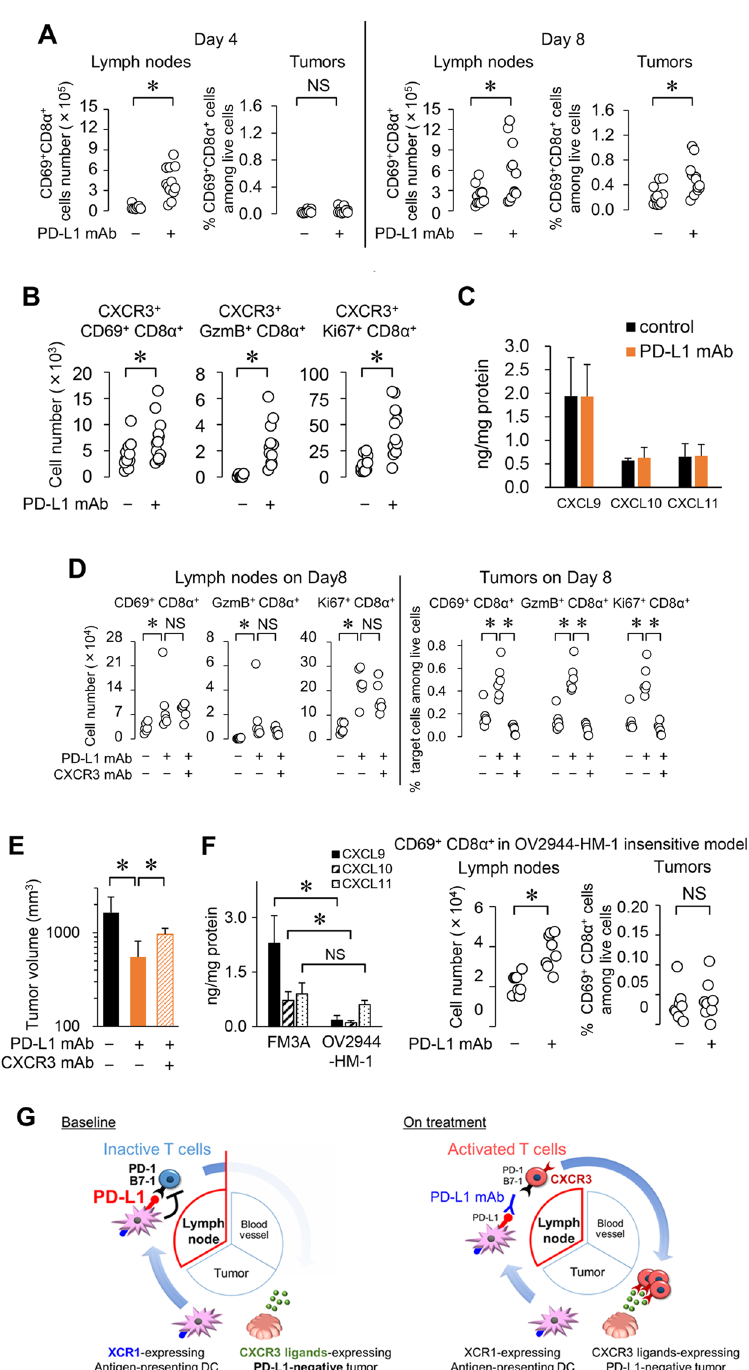
Figure 5. Time lag between the increase in activated CD8α + T cells in lymph nodes and the increase in the tumor is caused by T cell trafficking to a TC0/IC0 tumor. ( A ) Time course of CD8α + T cell activation in tumor-draining lymph nodes and in tumor after anti-PD-L1 mAb treatment in the FM3A model (Day 4, 8) ( n = 12/group). ( B ) Number of CXCR3 + activated CD8α + T cells in lymph nodes after anti-PD-L1 mAb treatment (Day 8) ( n = 12/group). ( C ) Expression of CXCR3 ligands in tumor (Day 8) ( n = 6/group). After mice were euthanized by exsanguination on Day 8, tumors were collected and homogenized. ( D ) Number of activated CD8α + T cells in lymph nodes and in tumors after anti-PD-L1 mAb treatment with or without CXCR3 blockade (Day 8) ( n = 6/group). ( E ) Tumor volume of mice treated with anti-PD-L1 mAb along with anti- CXCR3 mAb in the FM3A tumor model. (Day 18) ( n = 6/group). ( F ) Expression of CXCR3 ligands in tumors of FM3A and OV2944-HM-1 (left). Number of activated CD8α + T cells in lymph nodes (middle) and in tumors (right) after anti-PD-L1 mAb treatment (Day 8) ( n = 8/group). Data are shown as the mean + SD. Statistical analysis used Wilcoxon rank sum test and the Holm–Bonferroni method. * P < 0.05; NS not significant. ( G ) Hypothesis for mechanism of action of anti-PD-L1 mAb in the PD-L1-negative and immune desert-like tumor model based on the cancer–immunity